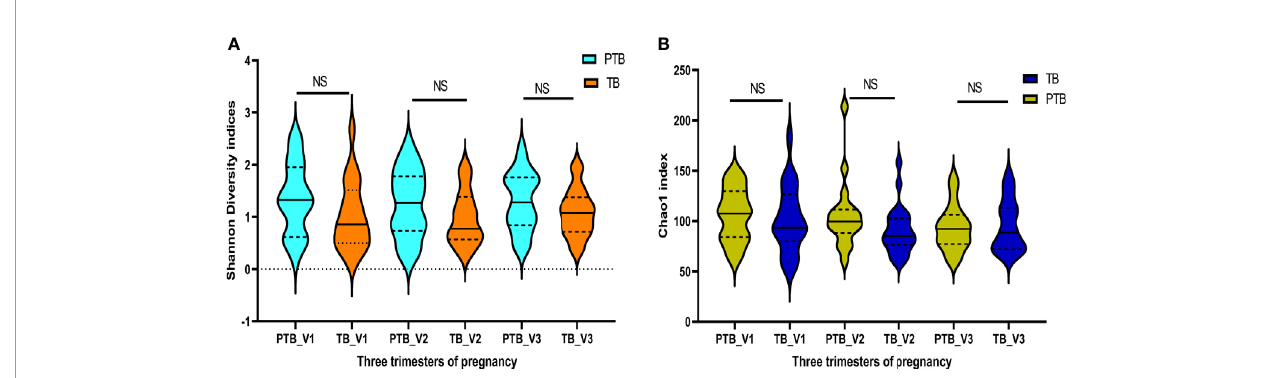
FIGURE 1 | Diversity indices: Intra- individual diversity (alpha diversity) is not signi fi cantly different between preterm and term delivering mothers. (A) Shannon diversity indices, (B) Chao1 indices, at different trimester of pregnancy. ns, non-signi fi